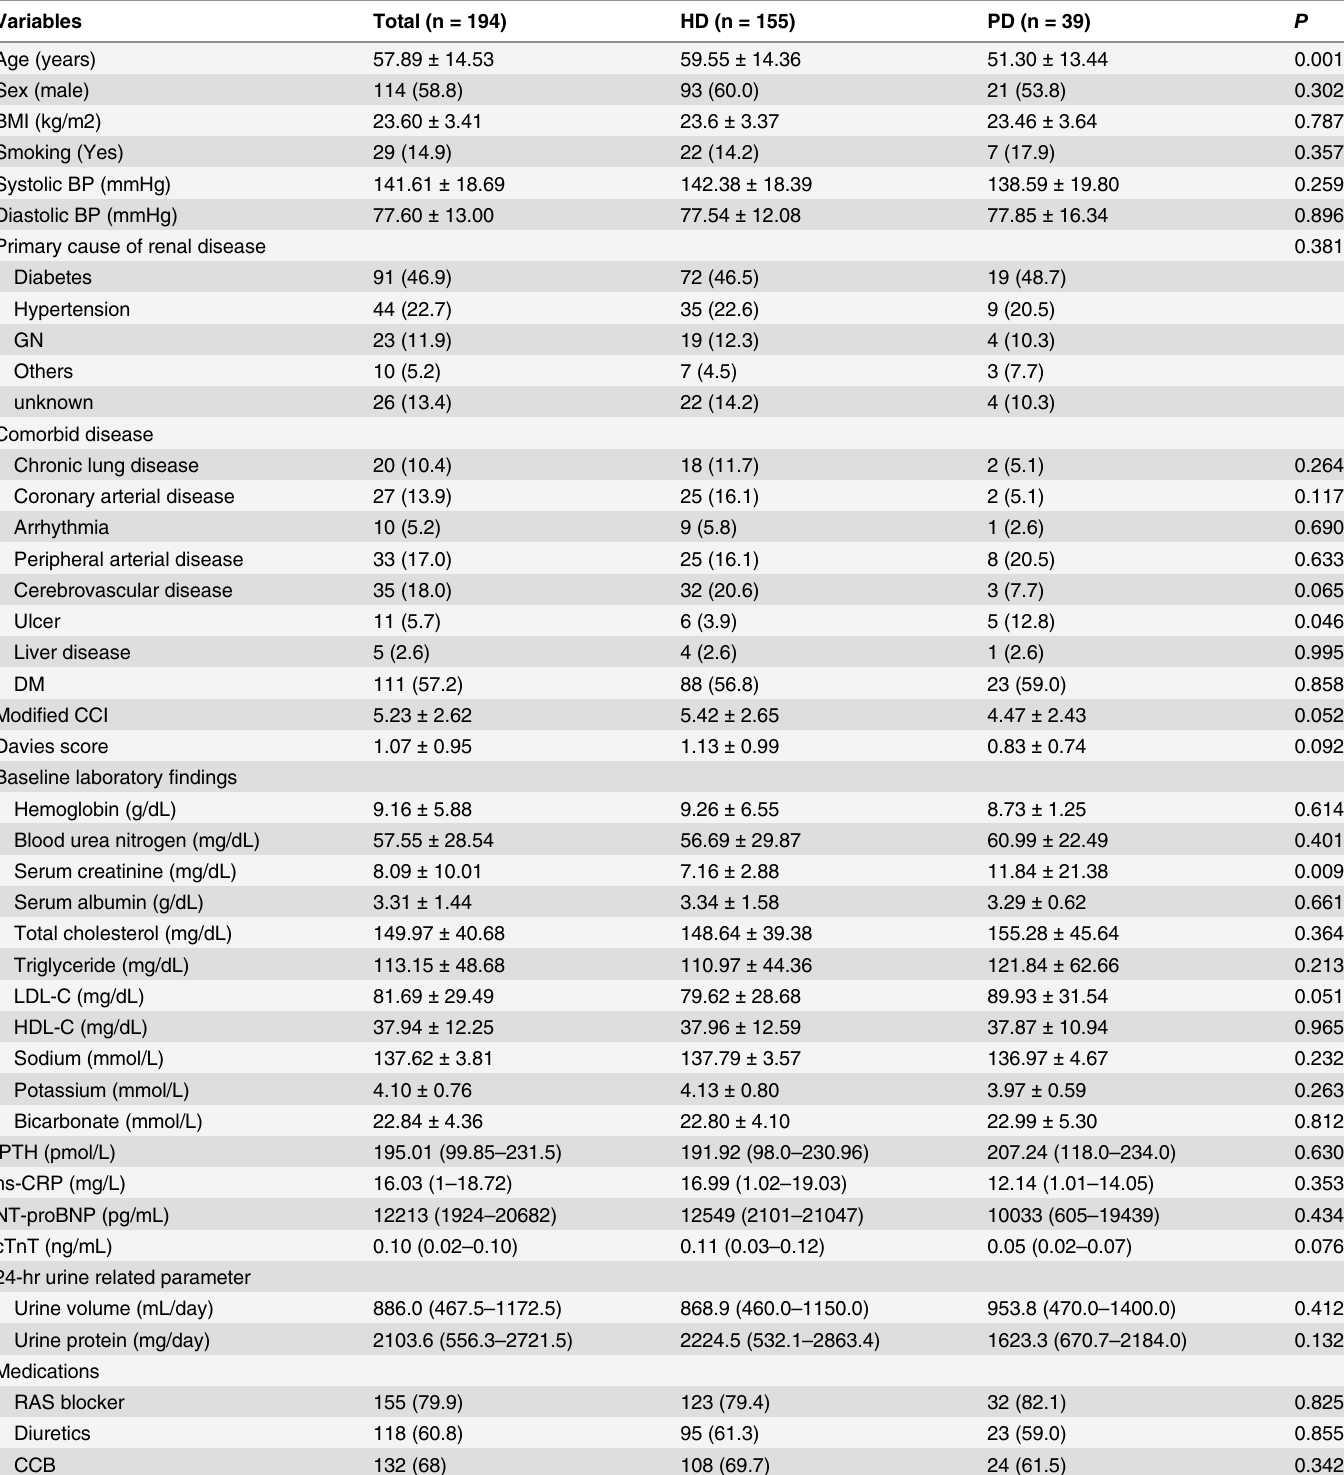
Table 1. Baseline characteristics of the study